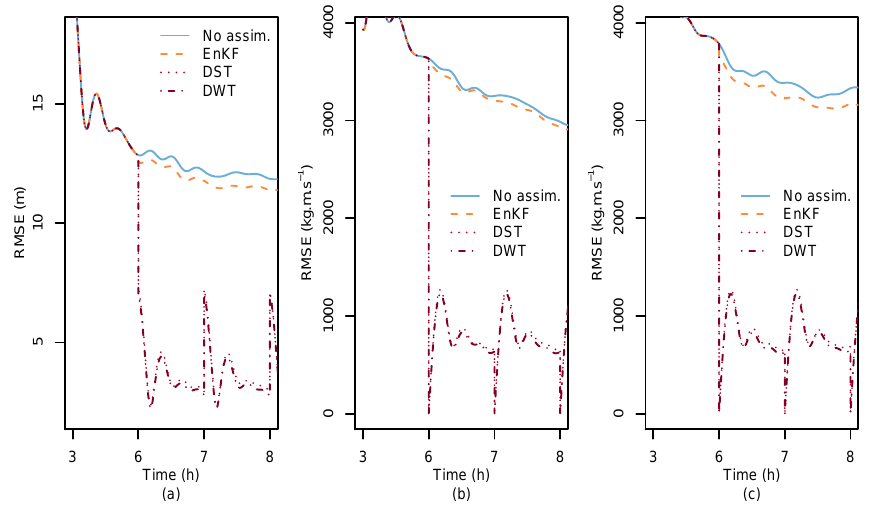
Figure 4. RMSE of ensemble mean of one realization of three assimilation cycles. Full state was observed. The length of assimilation cycle is 60min, ensemble size 20. (a) Water height, (b) velocity in the x direction and (c) velocity in the y